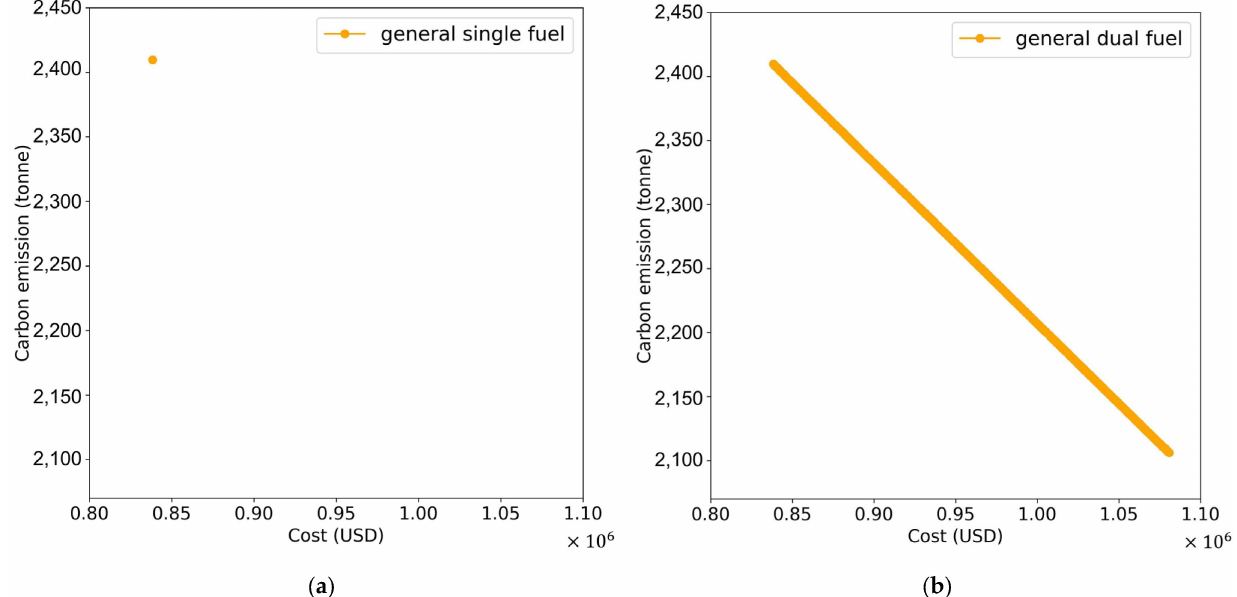
Figure 6. PF figures for a ( a ) general single-fuel ship and ( b ) general dual-fuel ship. ( a ) The carbon emission and the cost had no trade-off on single-fuel ship; thus, it was one optimal solution and a single point on PF figure. ( b ) For the general LNG dual-fuel ship, the two objectives had conflicts, and the optimal solutions would become a straight